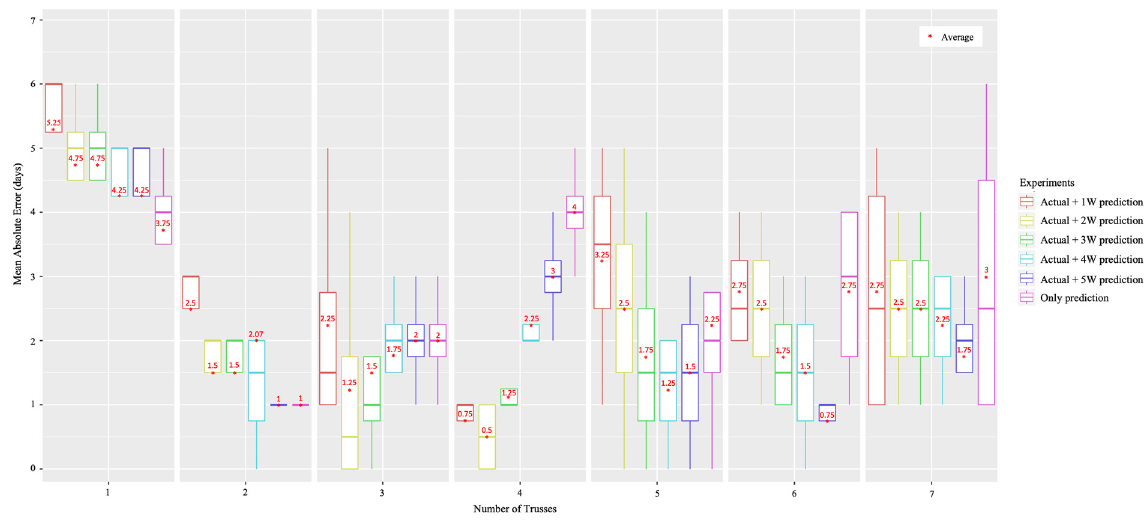
Figure 17. Mean Absolute Error (MAE) between the actual harvest date and predicted harvest date for each truss.